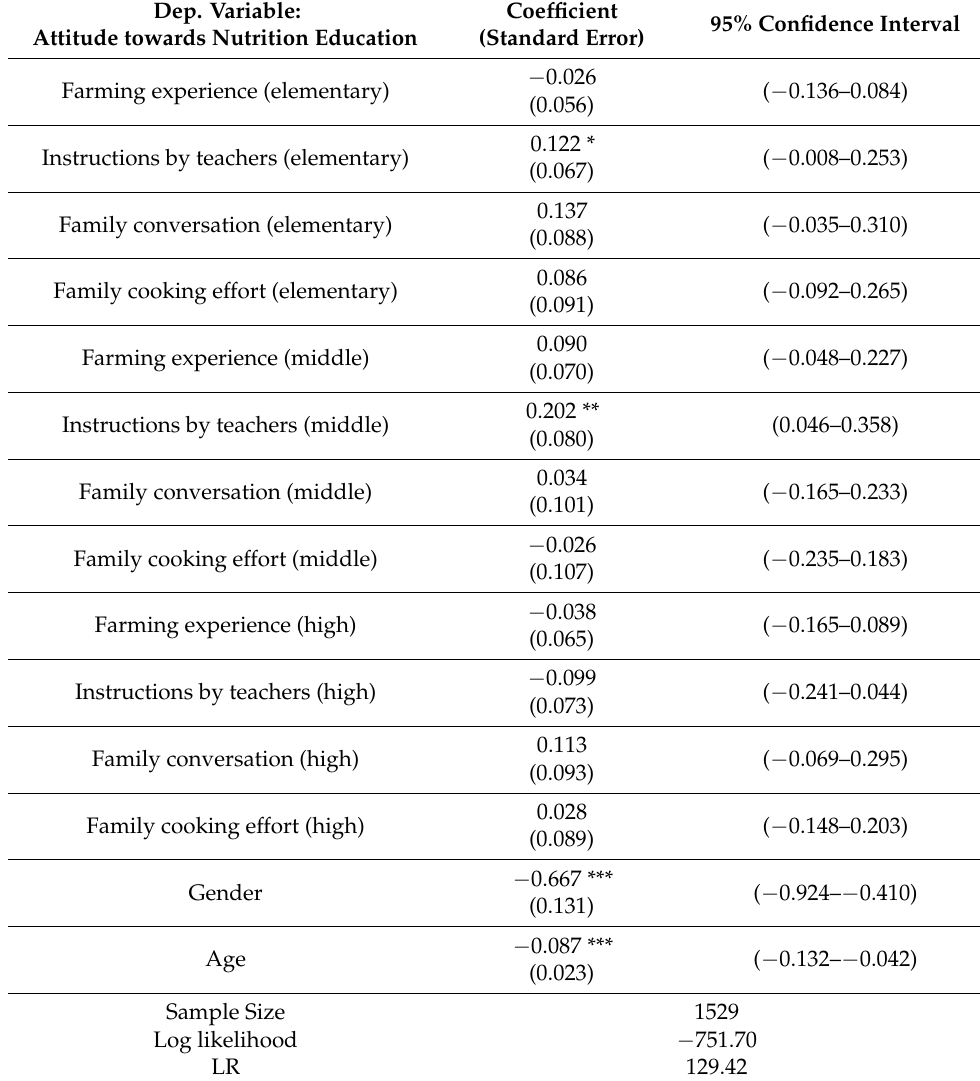
Logistic regression on the effects of nutrition education on attitude towards nutrition